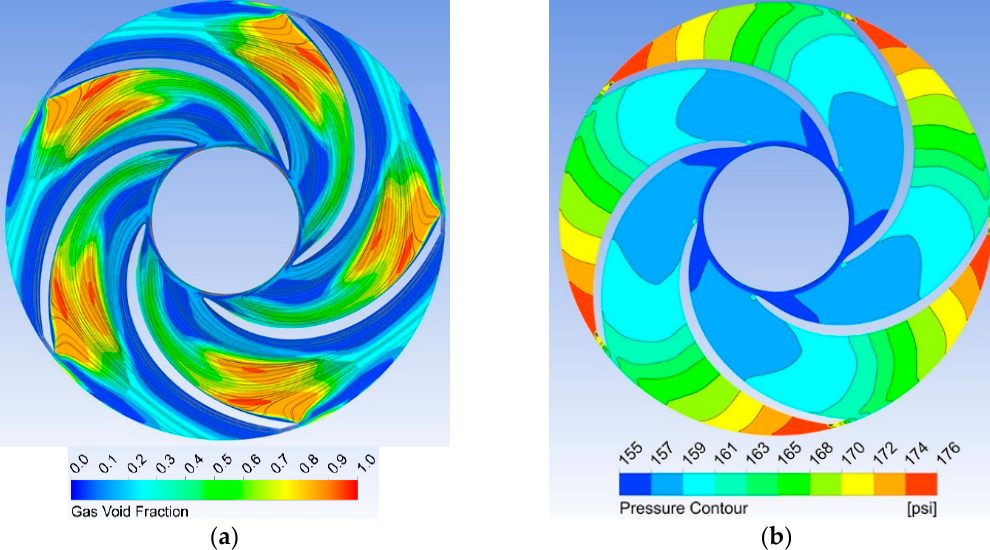
Figure 14. CFD predicted gas void fraction distribution and the corresponding pressure contour [90], ( a ) gas void fraction color map; ( b ) pressure contour on half impeller span.